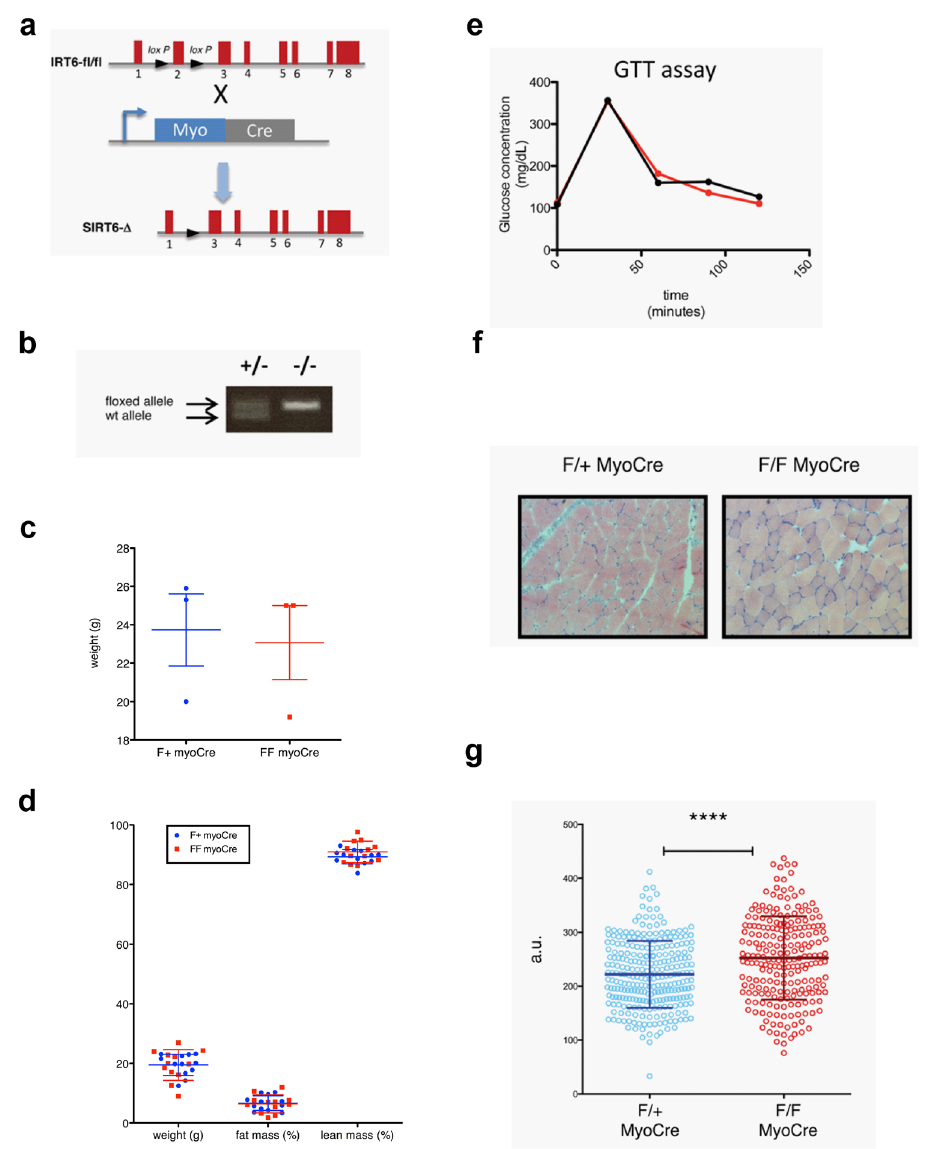
Fig.5|Phenotypiccharacterizationofmuscle-speci fi cSIRT6de fi cientmiceline generatedusingmyogenincre.a DiagramshowingthedeletionofSirt6inskeletal muscle. C57BL/6 mice containing fl oxed alleles of Sirt6 30 were crossed with trans- genic mice carrying cre under the control of the muscle-speci fi c myogenin pro- moter. Myogenin-Cre triggered the recombination of the fl oxed allele resulting in the deletion of sirt6 speci fi cally in muscle. b PCR of genomic DNA extracted from thetailofmyogenincremicethatwereheterozygous(F/+MyoCre)orhomozygous (F/F MyoCre) for the fl oxed sirt6. c Body weight of F/+ MyoCre and F/F MyoCre mice. n =3. d Body composition of F/+ MyoCre and F/F MyoCre mice. n =12.